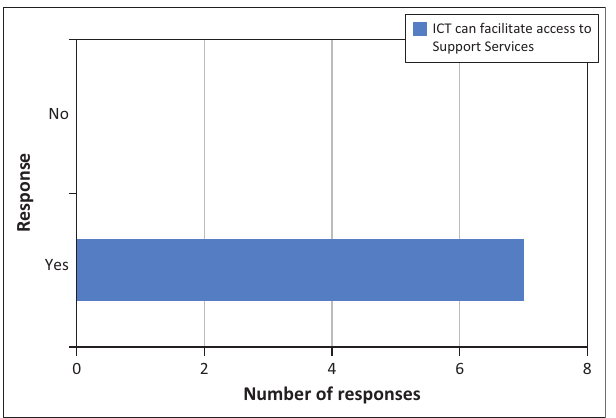
FIGURE 7: Case engagement of peers and stakeholders.